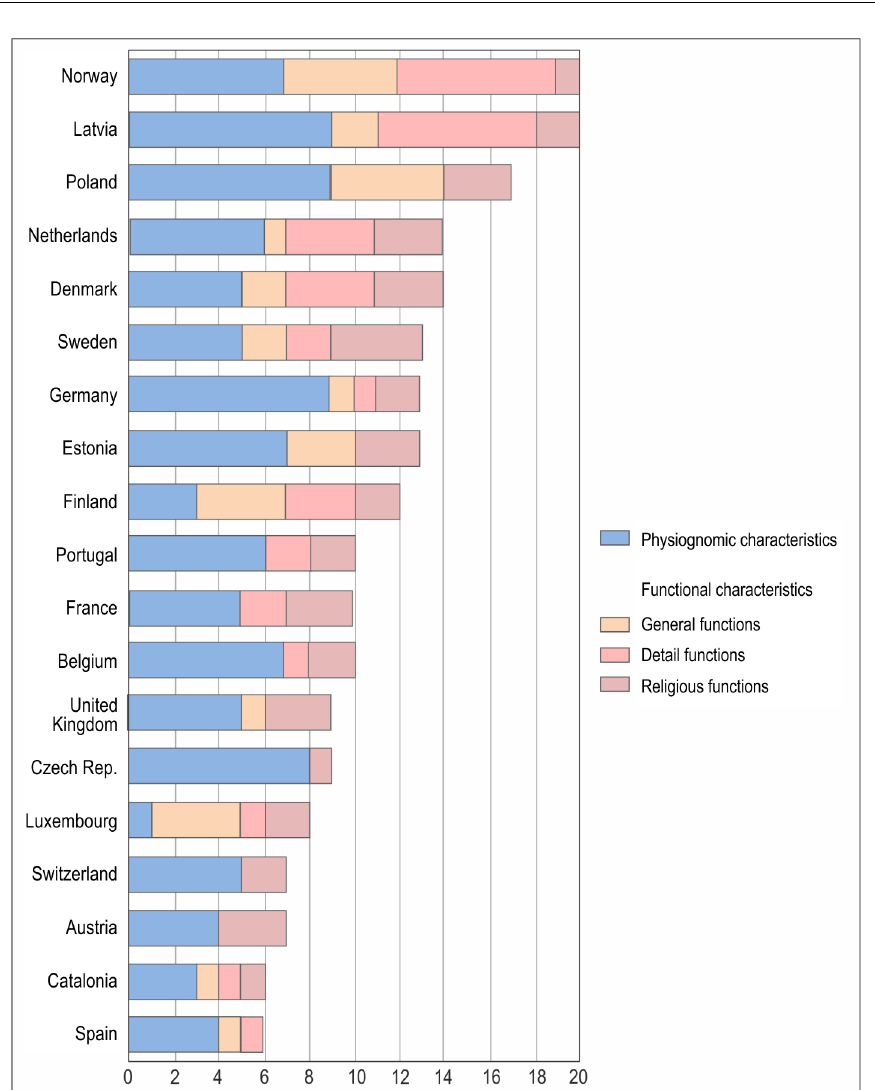
Fig. 3. The number of characteristics of buildings, structures and build-up areas on 1:50,000